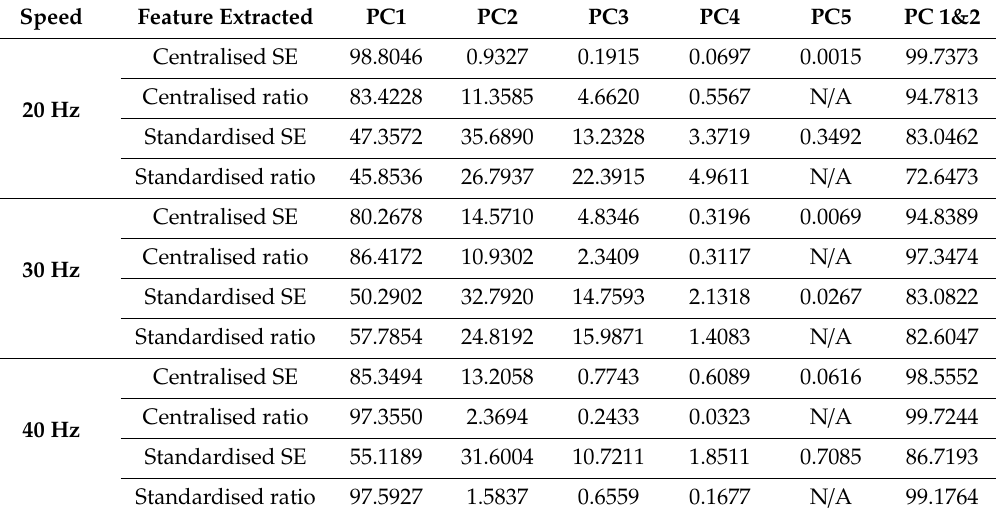
Table 3. Percentage of explained variance by each PC.